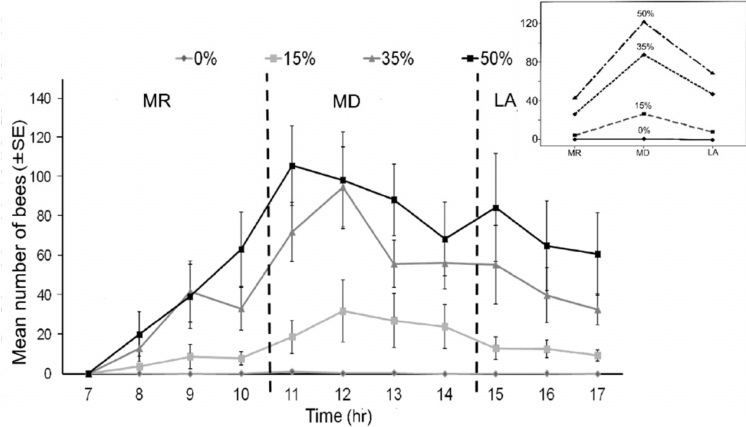
Figure 4. The mean number of stingless bee, Heterotrigona itama, that visited the different sugar concentrations (0%, 15%, 35%, and 50%) at different times within an 11-h period. The 11 h of the experiment were divided into three time categories, i.e., morning (MR; 7:00 h–10:40 h); midday (MD; 11:00 h–14:40 h); and late afternoon (LA; 15:00 h–17:40 h). Inset: The interaction plot of the mean number of bees visiting feeders with different sucrose concentrations across the three time